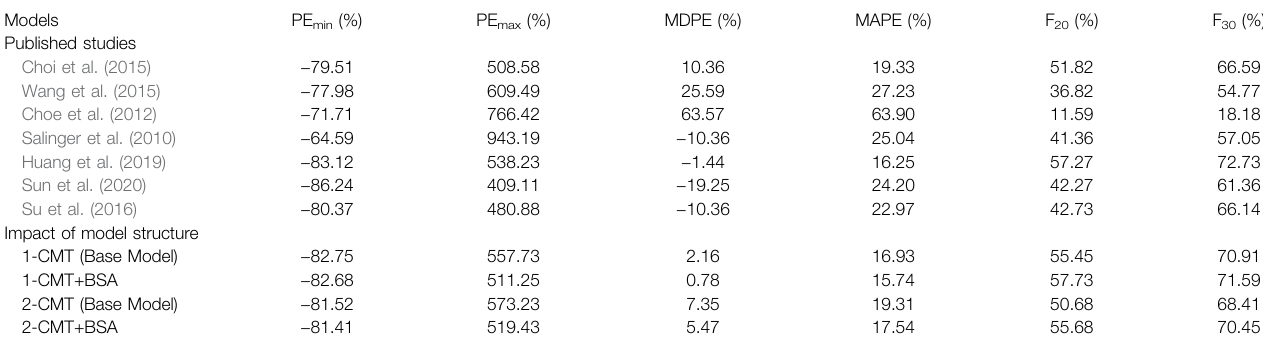
TABLE 3 | Results of prediction-based diagnostics.